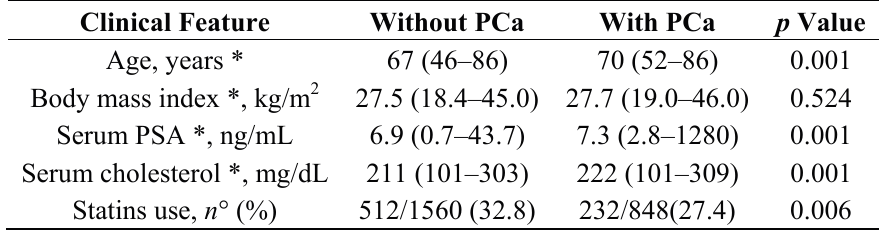
Table 1. Clinical characteristics according to the diagnosis of prostate cancer.